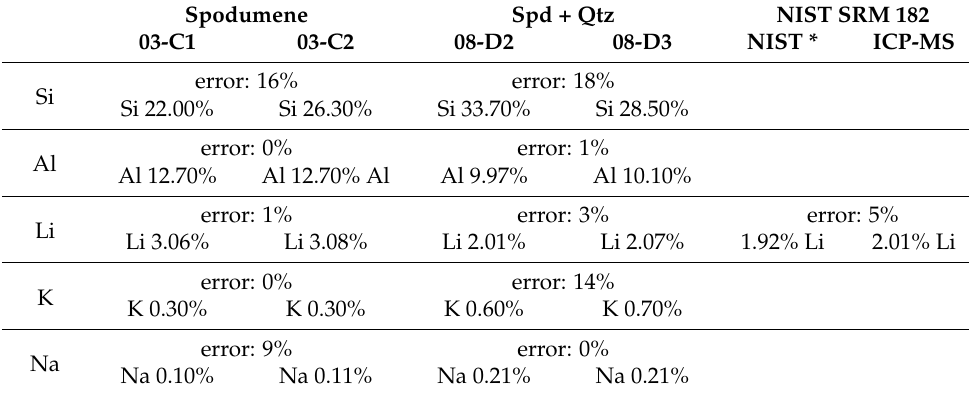
Table 3. ICP-MS errors in the samples sent for quality control (QC).